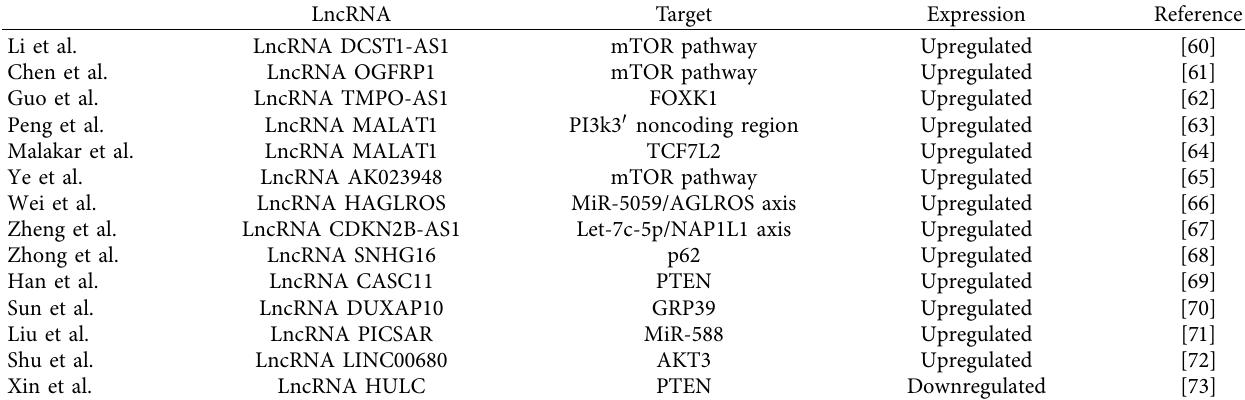
Table 2: Dysregulated lncRNAs in